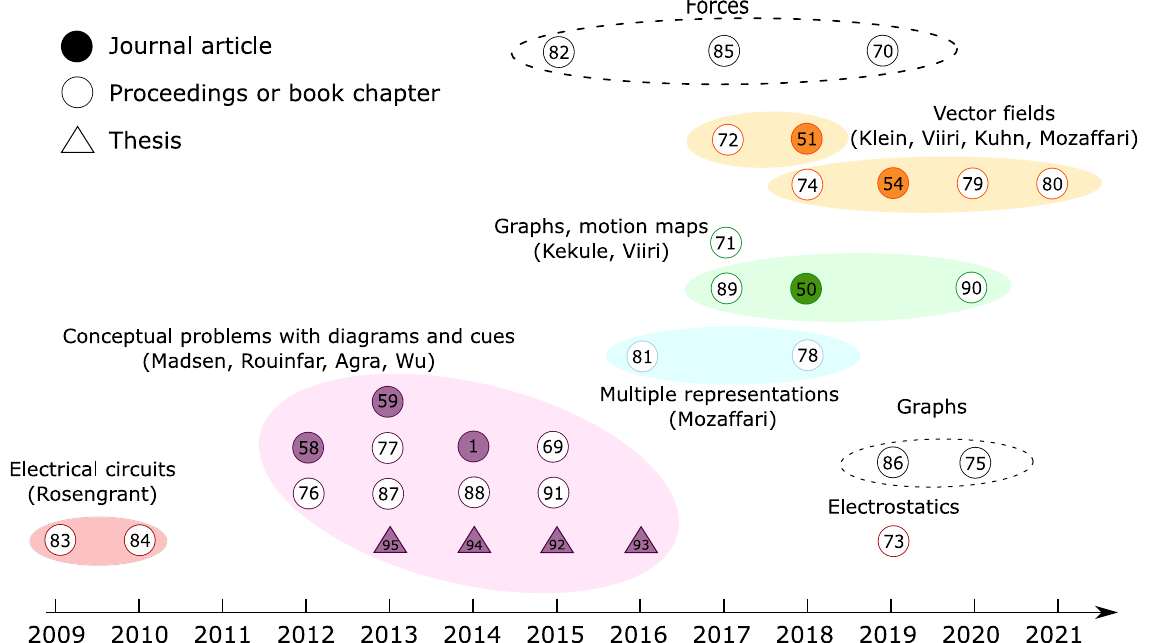
FIG. 4. Avisual summary of all proceedings and book chapters identified in the search ( k ¼ 23 ; circles not filled in color). Associated journal articles (circles filled in color) and Ph.D. theses ( N ¼ 4 ; triangles) to these records are also presented. The colored ellipses indicate related studies from overlapping author groups. The dashed ellipses indicate thematically related studies from different author groups. The numbering refers to the references in the